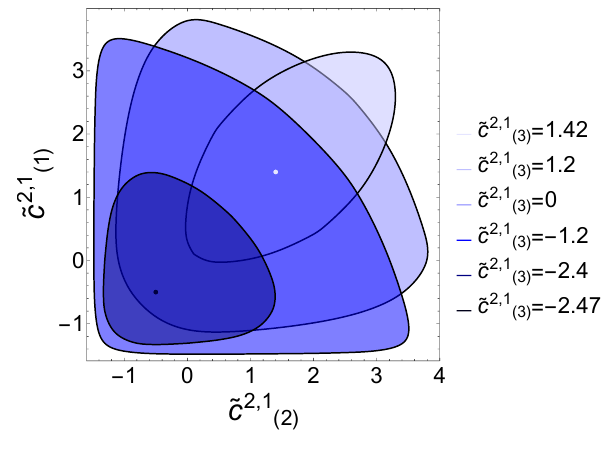
= ˜ c 2 , 1 = ˜ c 2 , 1 = 4˜ c 2 , 1 ) for Z symmetric bi-scalar , ˜ c 2 , 1 , ˜ c 2 , 1 2 1111 2222 1122 (1) (2) (3) . We (1) = ˜ c 2 , 1 = 0 and set ˜ c 2 , 0 to 1 (without (4) (4) (2)